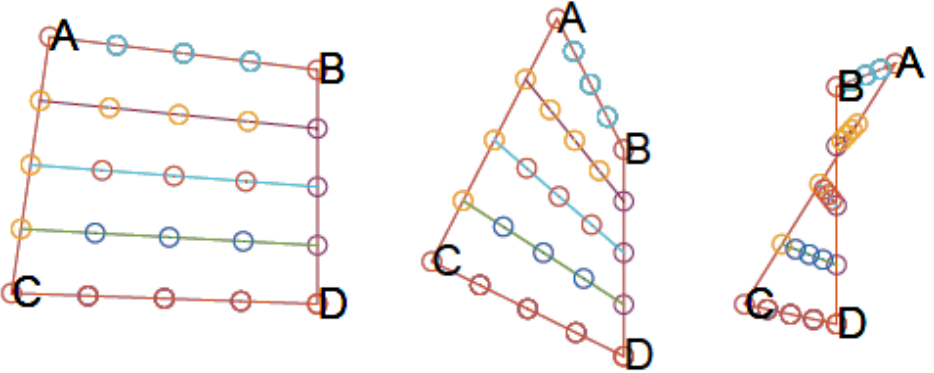
Figure 5. Representation of a ColQuad with a subdivision factor of five from three different per- spectives. Note: in this example point A is not on the plane defined by BCD. The ColQuad is not a quadrilateral restricted to 2D but a 3D